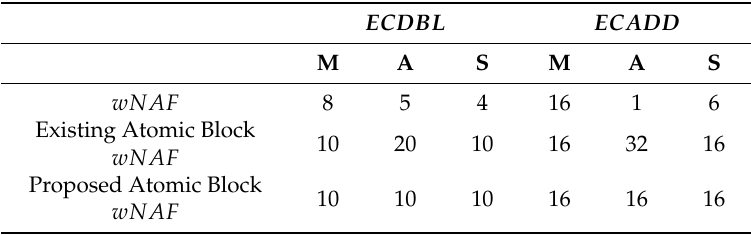
Table 8. Operation count comparison ( M : Field multiplication, A : Field addition, and S : Field